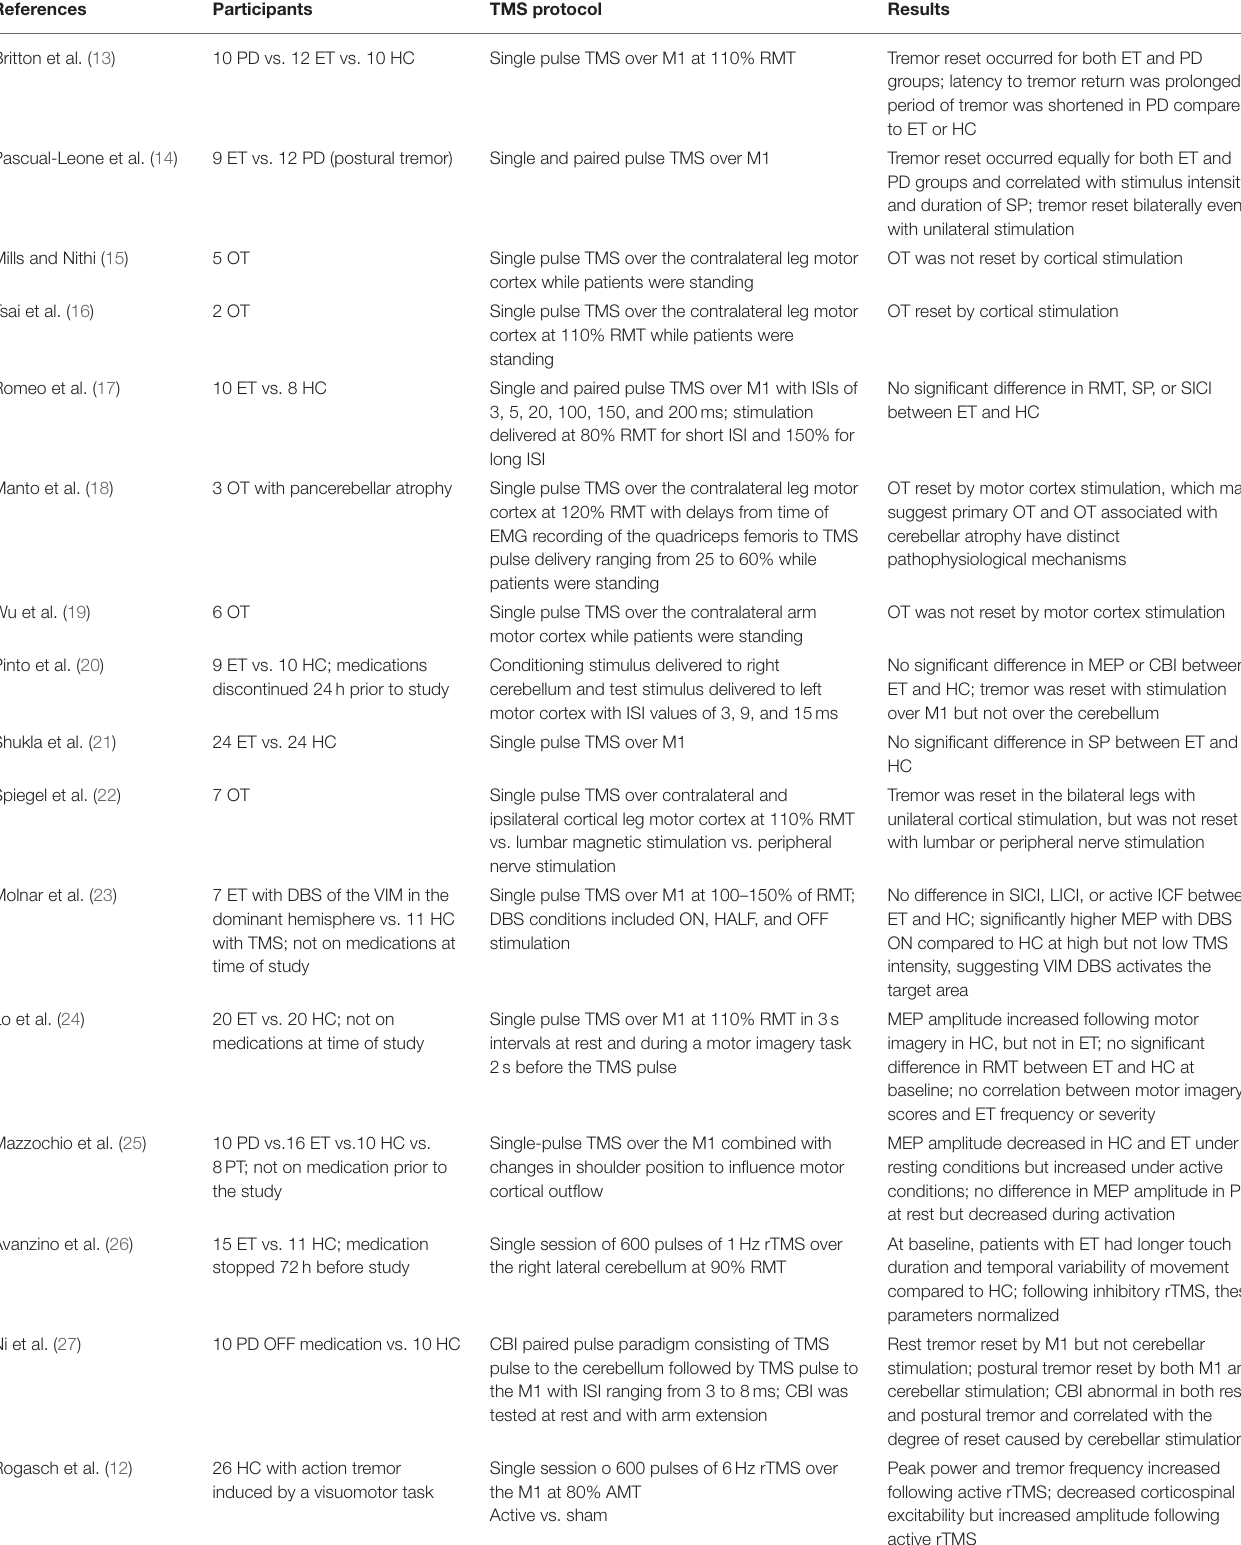
TABLE 1 | TMS studies for understanding the pathophysiology of tremor